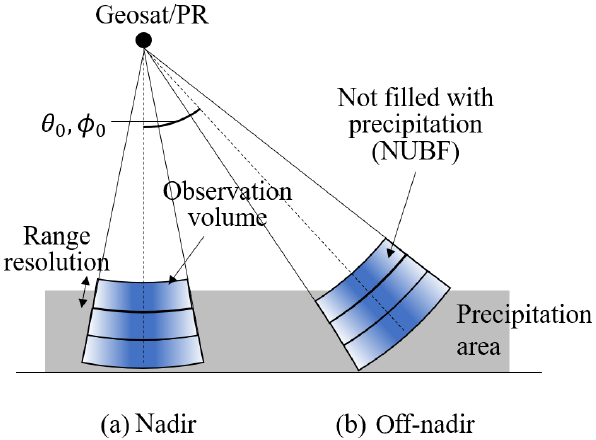
Figure 4. Schematic image of the scattering volume at (a) nadir and (b) off-nadir.